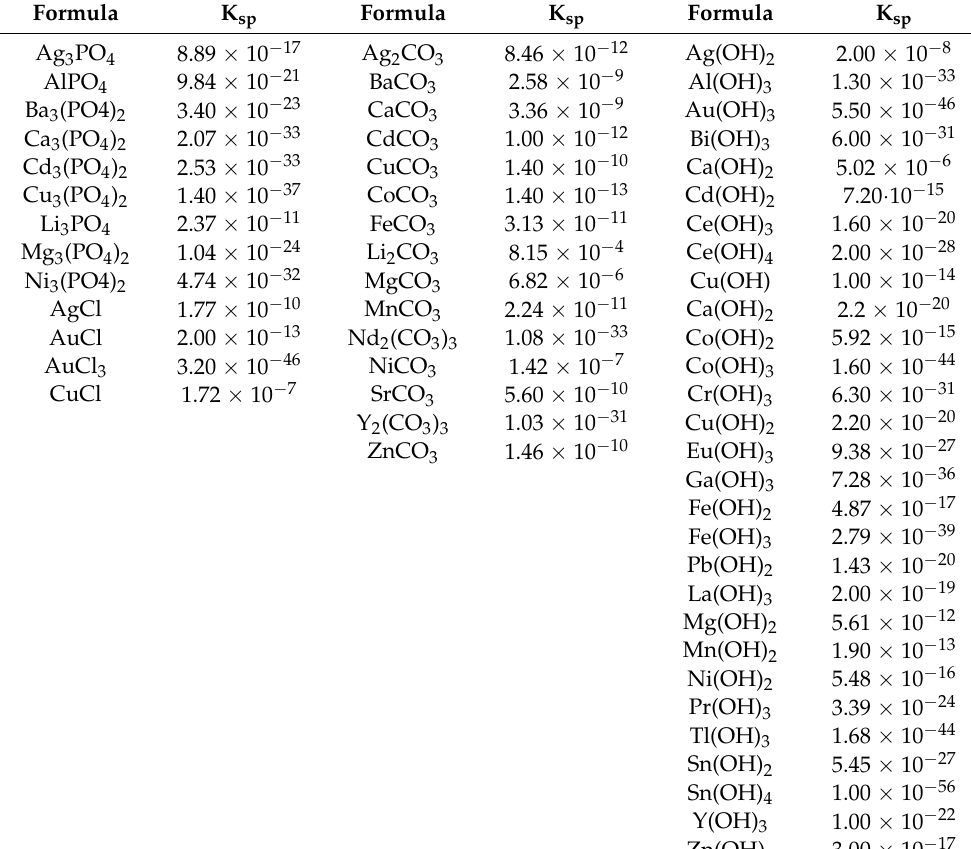
Table 2. The solubility product constant K sp values at 25 ◦ C